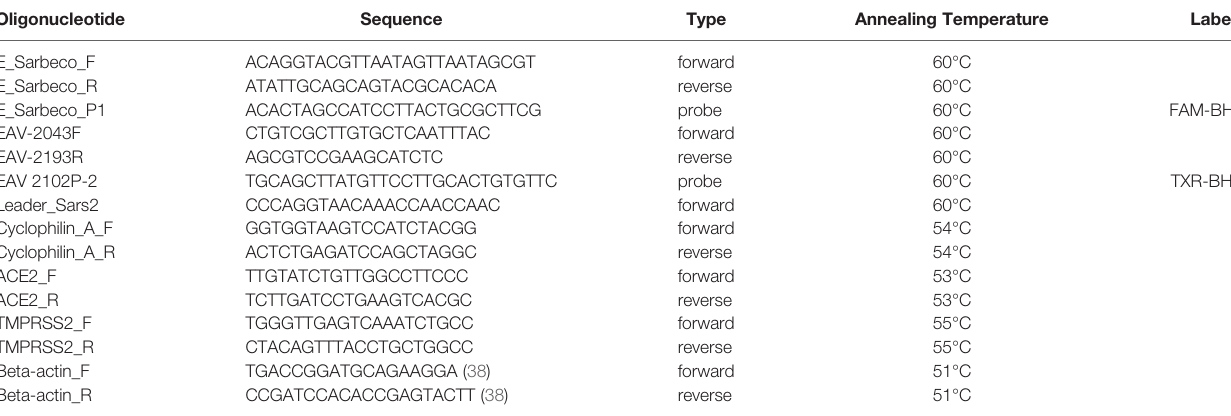
TABLE 1 | Primers and probes used in this study.